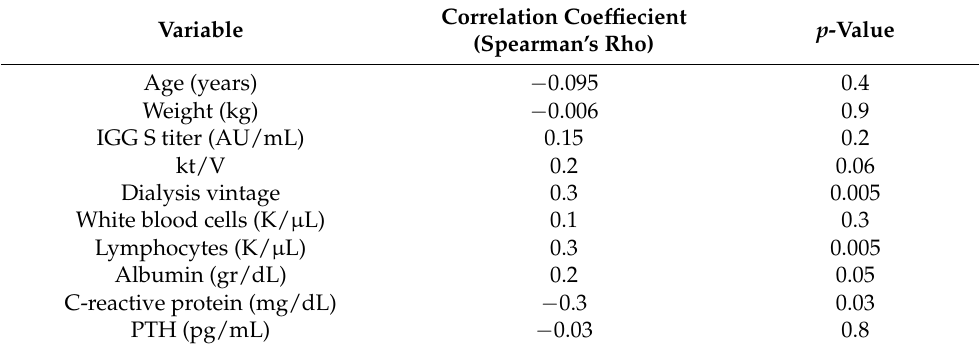
Table 2. Variables that were correlated with HBsAb titers. Variable